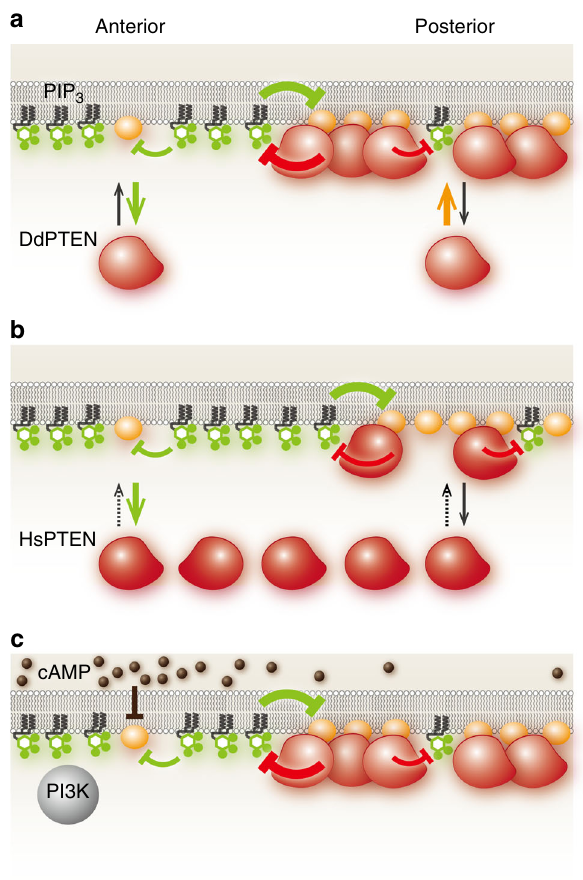
Fig. 6 A model explaining the molecular mechanism for con fi ning and localizing PIP3 enrichment. a Clear spatial separation between DdPTEN and PIP3 established via mutual inhibition in the presence of negative regulation and phosphatase activity. b Enlargement of the PIP3-enriched domain by the replacement of DdPTEN with HsPTEN, which lacks suf fi cient membrane localization. c Chemotactic signaling excludes DdPTEN from the higher concentration side by suppressing the binding site for the stably